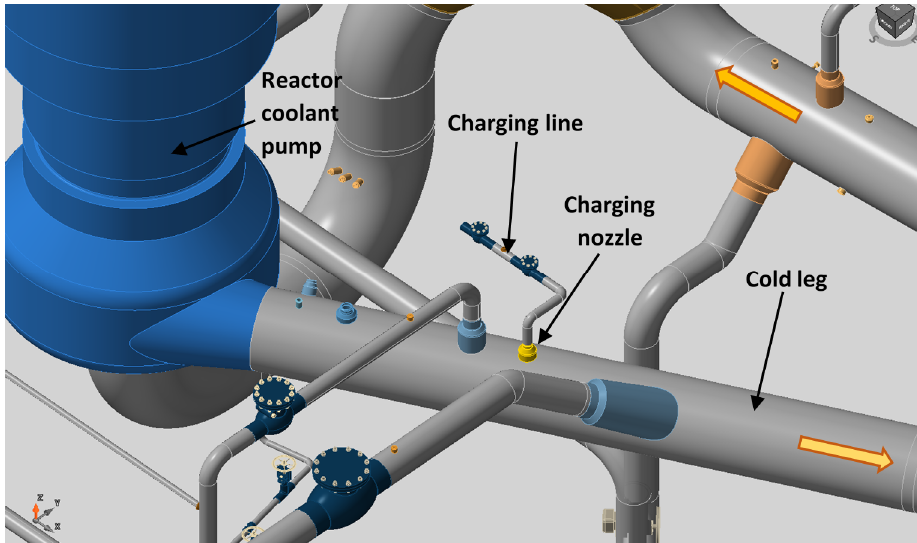
Figure 3. Scheme of the different components involved and location of the charging nozzle within the whole system. Yellow arrows indicate the direction of flow.